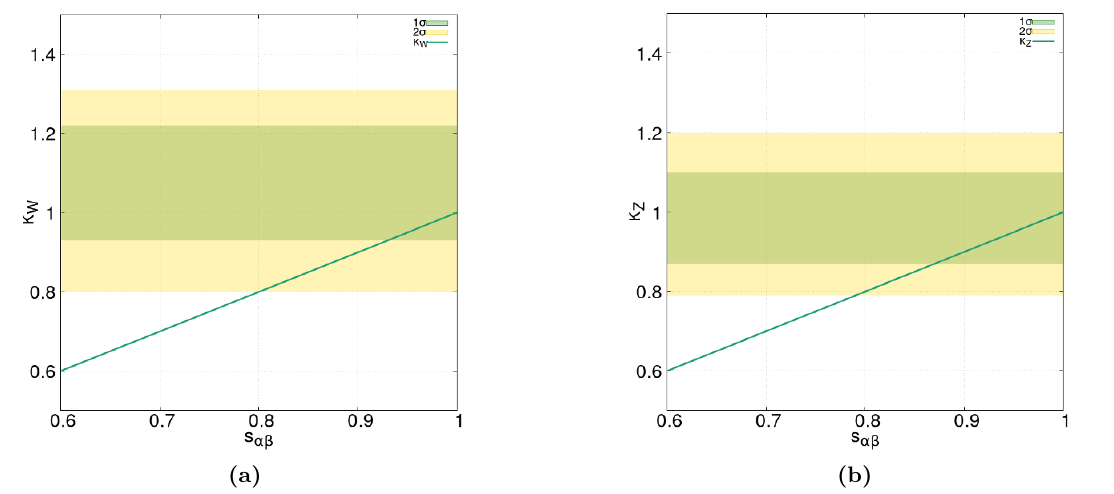
Figure 1. (a) (cid:20) W and (b) (cid:20) Z coupling modi(cid:12)ers as a function of s (cid:11)(cid:12) . The dark areas represent the allowed regions by the experimental constraints at 1 (cid:27) and 2 (cid:27)